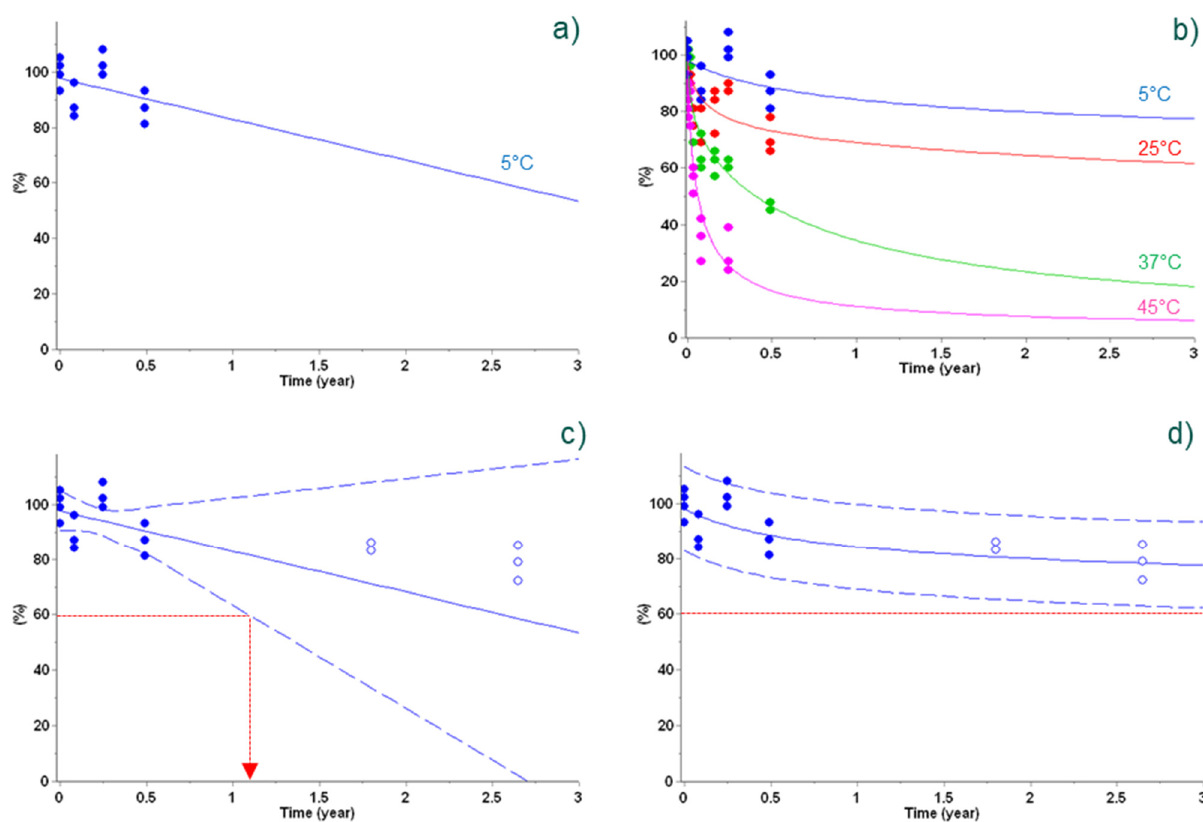
Figure 4. Antigenicity predictions of vaccine using a classical linear regression (left column) and non-linear regression (i.e., advanced kinetics, right column) of 6 months’ data points (full circles). Data at +5 °C (blue) were used for linear regression (panel ( a )), whereas additional data at +25 °C (red), +37 °C (green), and +45 °C (pink) were also used for non-linear regression (panel ( b )). Antigenicity predictions are displayed as lines based on the linear model (left column) and best kinetic model (right column), including a 95% two-sided confidence level for the mean for the linear model (dashed lines, panel ( c )) and 95% bootstrap predictive band for the kinetic model (dashed lines, panel ( d )). Additional experimental data obtained later in time are displayed as open circles for verification (panels ( c , d )). The lower acceptance limit at 60% is displayed as dotted red lines (panels ( c , d )). Reproduced from Clénet (2018), Copyright © 2018, with permission from Elsevier for right column.